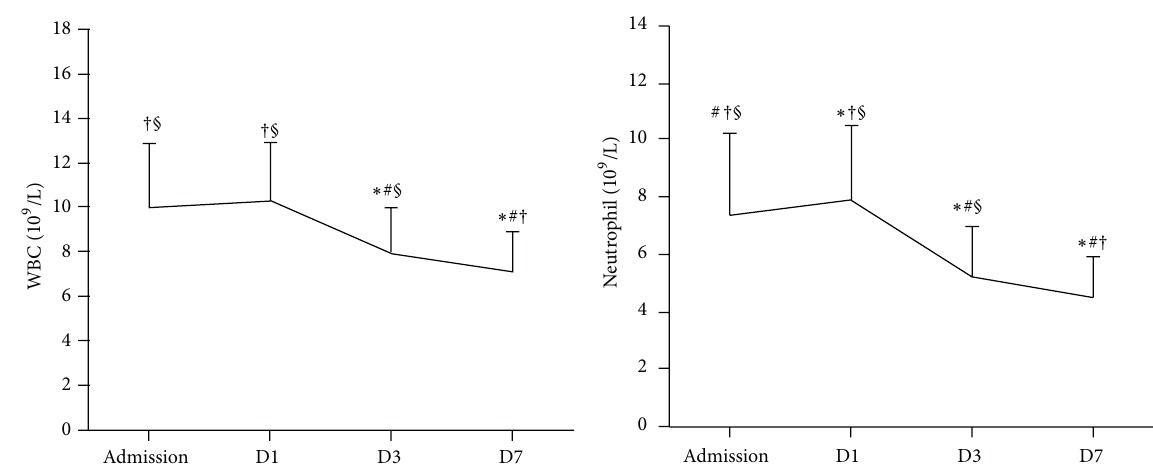
Figure 1: The time course of WBC and neutrophil in patients with STEMI who received successful PPCI ( 𝑛 = 357 ). ∗ Represents 𝑃 < 0.05 compared with admission, # represents 𝑃 < 0.05 compared with D1, † represents 𝑃 < 0.05 compared with D3, and § represents 𝑃 < 0.05 compared with D7. Note: D1: the first day, D3: the third day, and D7: the seventh